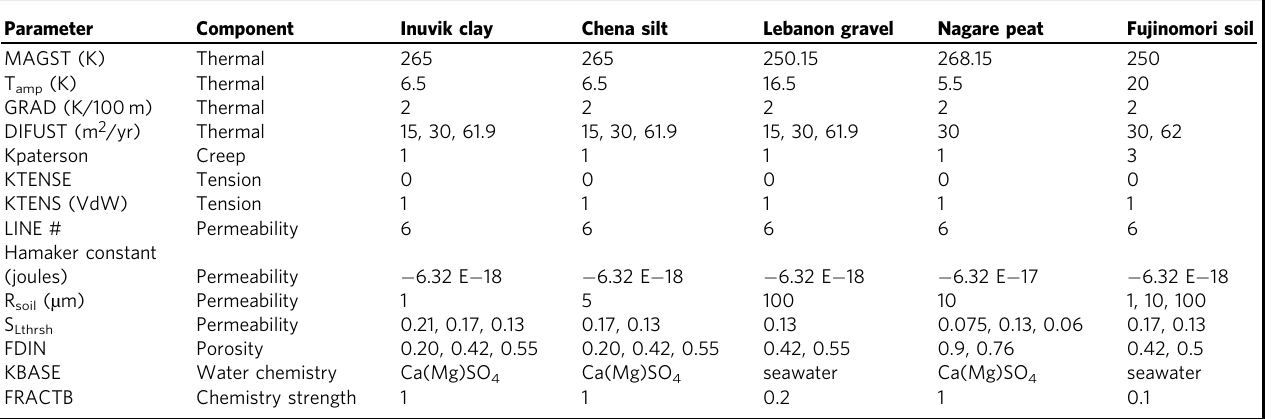
Fig. 6 Comparison of measured and modeled vertical distribution of ground ice in permafrost sediments. a Volumetric ice content pro fi le in Richardson Mountains/Peel Plateau region in NWT 28 (shown is the median of ground ice volume from 10 permafrost cores and averaged in 0.5 m bin interval) compared with a 50:50 mixture of Chena silt and Inuvik clay type sediment. b Volumetric ice content pro fi le at Friis Hills 27 compared with the negative depth derivatives of water speeds (dWS REGO /dZ) of Fujinomori soil type. c Gravimetric ice content pro fi le at Beacon Valley 26 compared with the negative depth derivatives of water speeds (dWS REGO /dZ) of Lebanon gravel. The negative depth derivatives of water speeds (dWS REGO /dZ) are used to indicate where ice accumulates by freezing or is removed by melting. Table 3 lists values of all parameters used in the WATEREGO ensemble simulation, in the square brackets are the mean annual ground surface temperature and its amplitude (in K) and the geothermal gradient (in K per 100 m). The colors of the lines in panels b and c correspond to the color of the x -axis titles. Note the change in scale for dWS REGO /dZ in the upper few meters. Table 3 Values of input parameters used in ensemble modeling with WATEREGO for Figs. 4 –